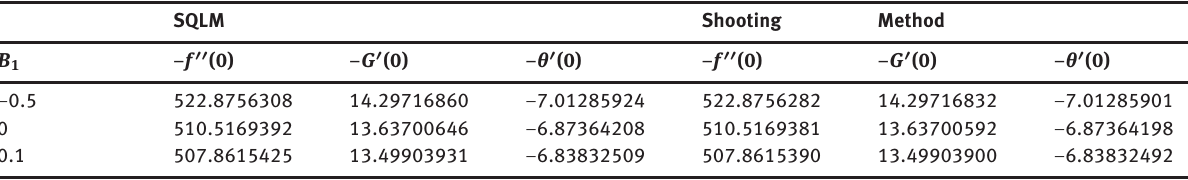
Table 1: Comparison of radial shear stress (− f (cid:2)(cid:2) (0)) , tangential shear stress (− G (cid:2) (0)) , heat transfer rate (− θ (cid:2) (0)) using SQLM and Shooting method for different values of B 1 in the absence of Hartman number, ion-slip parameter, Hall parameter, chemical reaction parameter, Soret and Dufour numbers, with Re = 500 .